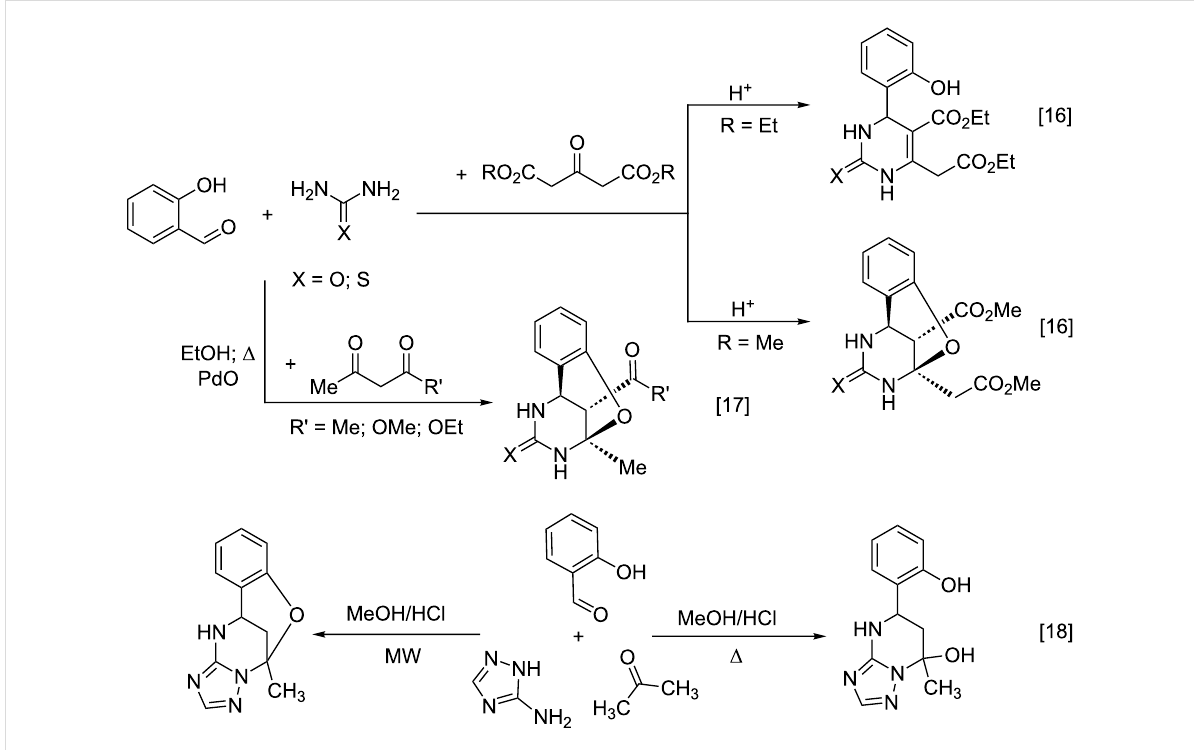
Scheme 2: Some Biginelli-type three-component condensations with